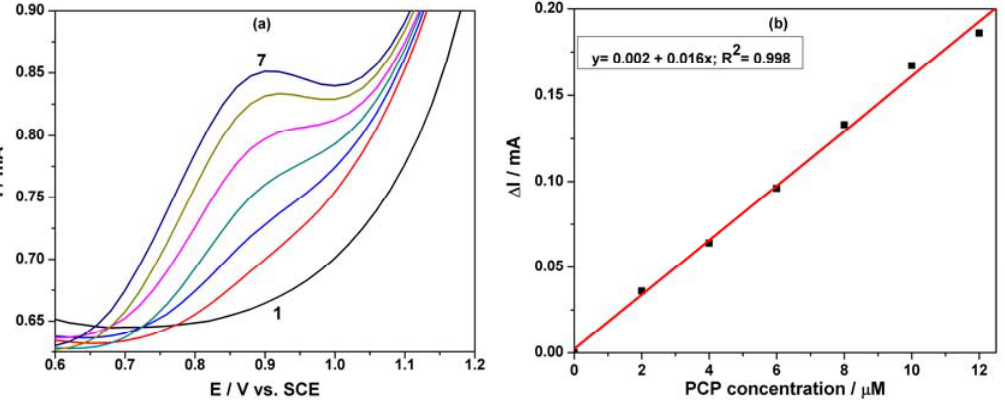
Figure 7. ( a ) SWVs of the MWCNT-EP composite electrode (modulation amplitude of 0.1 V, step potential of 0.01 V and frequency 10 Hz) in the potential range between +0.6 V and SO supporting electrolyte (curve 1) and in the presence of +1.2 V vs . SCE in 0.1 M Na 2 4 different PCP concentrations: (2) 2 µM; (3) 4 µM; (4) 6 µM; (5) 8 µM; (6) 10 µM; (7) 12